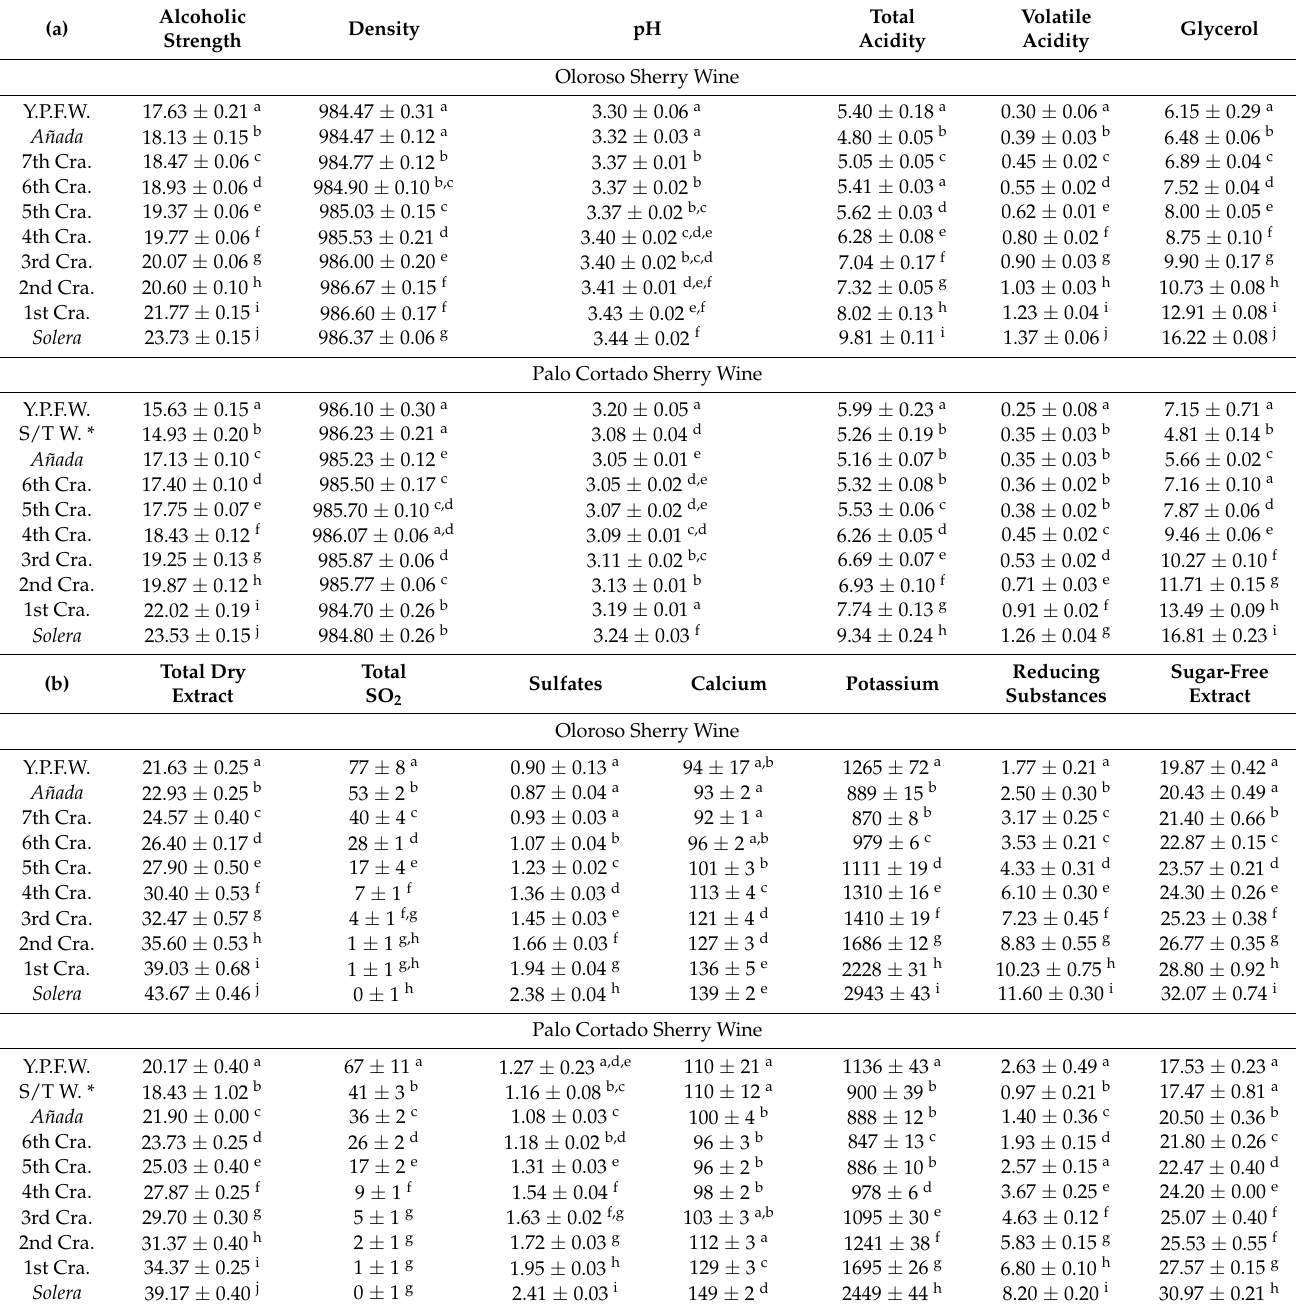
Table 4. Parameters of Oenological Control: (a) alcoholic strength (% ABV), density (g/L), pH, total acidity (g TH 2 /L), volatile acidity (g AcH/L), glycerol (g/L), in the Oloroso and Palo Cortado Sherry wines studied. (b) total dry extract (g/L), total sulfur dioxide (mg/L), sulphates (g K 2 SO 4 /L), calcium (mg/L), potassium (mg/L), reducing substances (g/L) and sugar-free extract (g/L) in the Oloroso and Palo Cortado Sherry wines